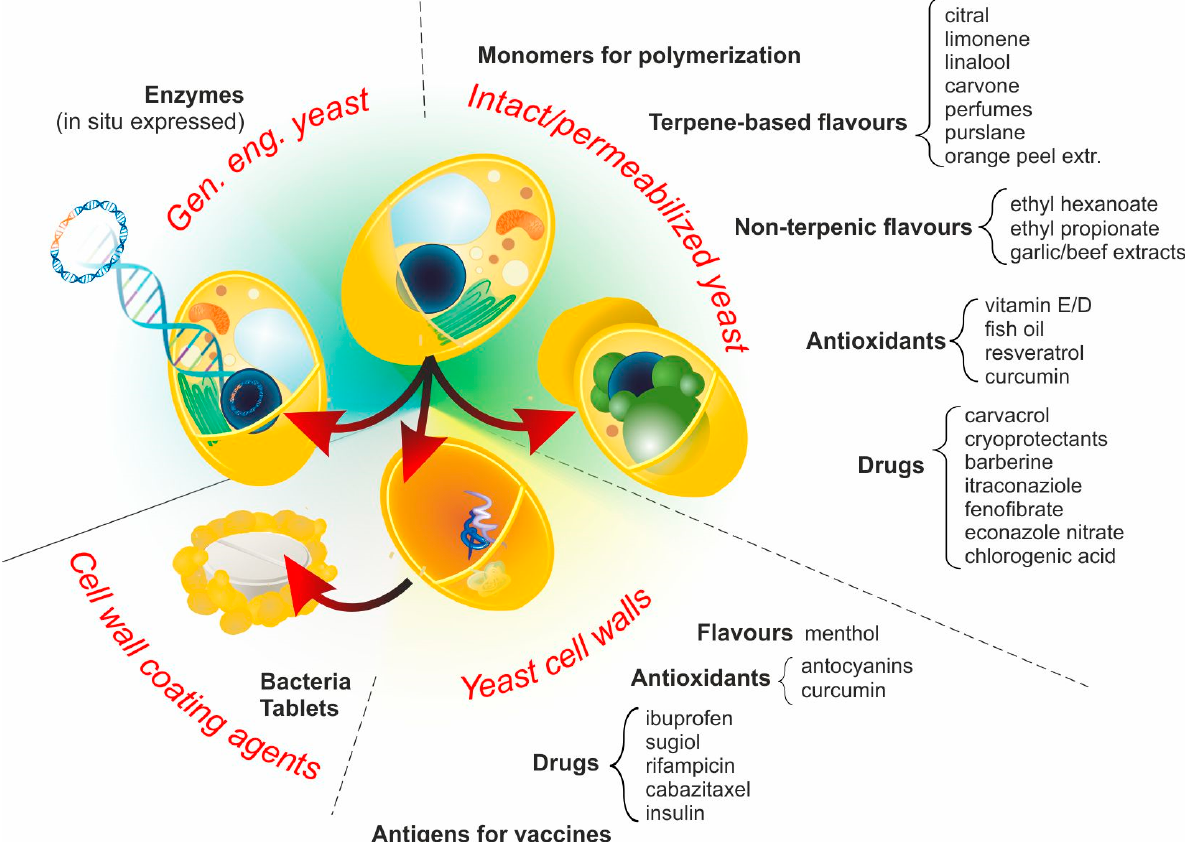
Figure 2. YBMCs can be grouped into four main classes, depending on whether intact or permeabilized cells, or their cell wall remnants are used for passive (diffusion-based encapsulation processes) or whether they are genetically engineered to produce one or more active compounds intracellularly. Examples of actives are provided for each class, and the corresponding references can be found in the text.